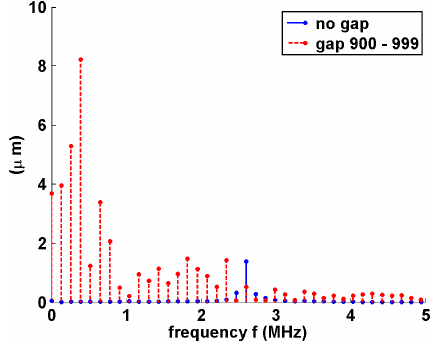
FIG. 17. Fourier analysis of the oscillation of an ion cloud interacting with a full bunch train and a bunch train with a 100 bunch gap from the 900th to 999th position in the